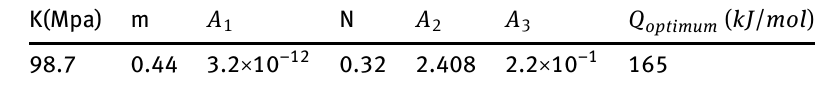
Table 1: Coeflcients predicted model for as-cast AZ30 magnesium alloys obtained from genetic algorithm.